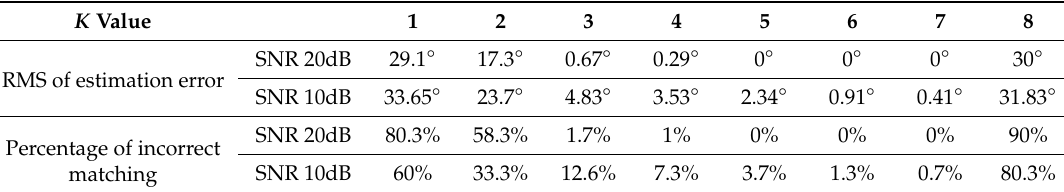
Table 2. Evaluation of K value on the DoA estimation accuracy of the proposed